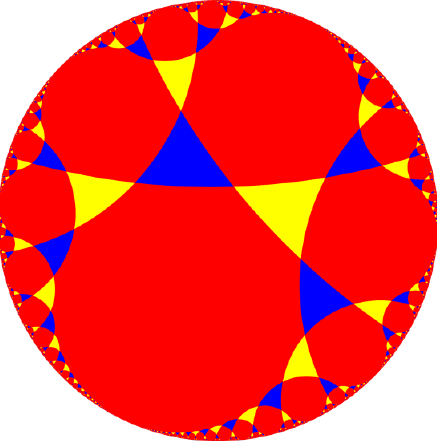
Figure 1 . Cayley graph of Z 3 ? Z 3 . The elements of the group live on the vertices of the triangles; the edges of the Cayley graph live on the edges of the triangles. Going around a blue (yellow) triangle clockwise corresponds to multiplication by R x ( R y ). Going around a blue (yellow) triangle counterclockwise corresponds to multiplication by R (cid:0) 1 R 3 = R 3 = 1. This Cayley graph happens to give a uniform tiling of the hyperbolic plane, which x y shows that Z 3 ? Z 3 is (cid:14) -hyperbolic.